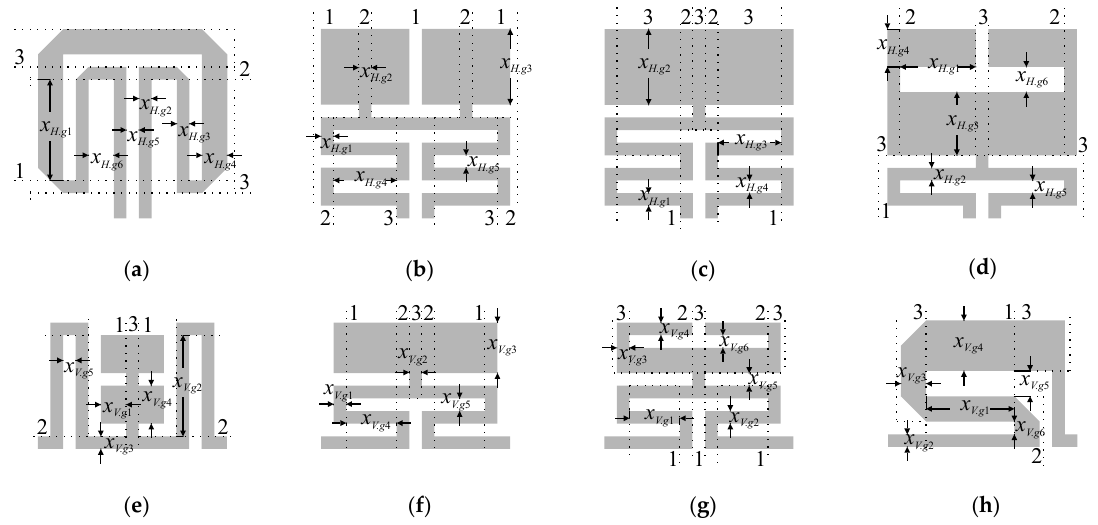
Figure 9. The database of compact cells used for automated BLC design. Dotted lines represent sub-sections of the substrate characterized by different permittivity/thickness pairs—each index k = 1, 2, 3, corresponds to ε rk / h k of the given sub-section. Four horizontal ( a ) C H (1) , ( b ) C H (2) , ( c ) C H (3) , ( d ) C H (4) and four vertical ( e ) C V (1) , ( f ) C V (2) , ( g ) C V (3) , ( h ) C V (4) cells are implemented. The structures are designed in the form of an equivalent-circuit and EM models.